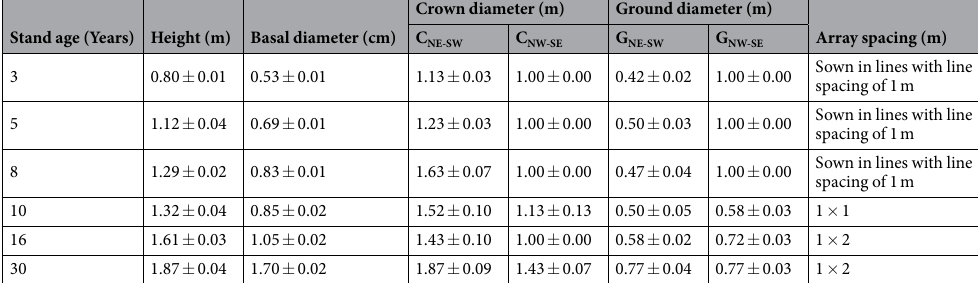
Stand age (Years) Height (m) Basal diameter (cm)